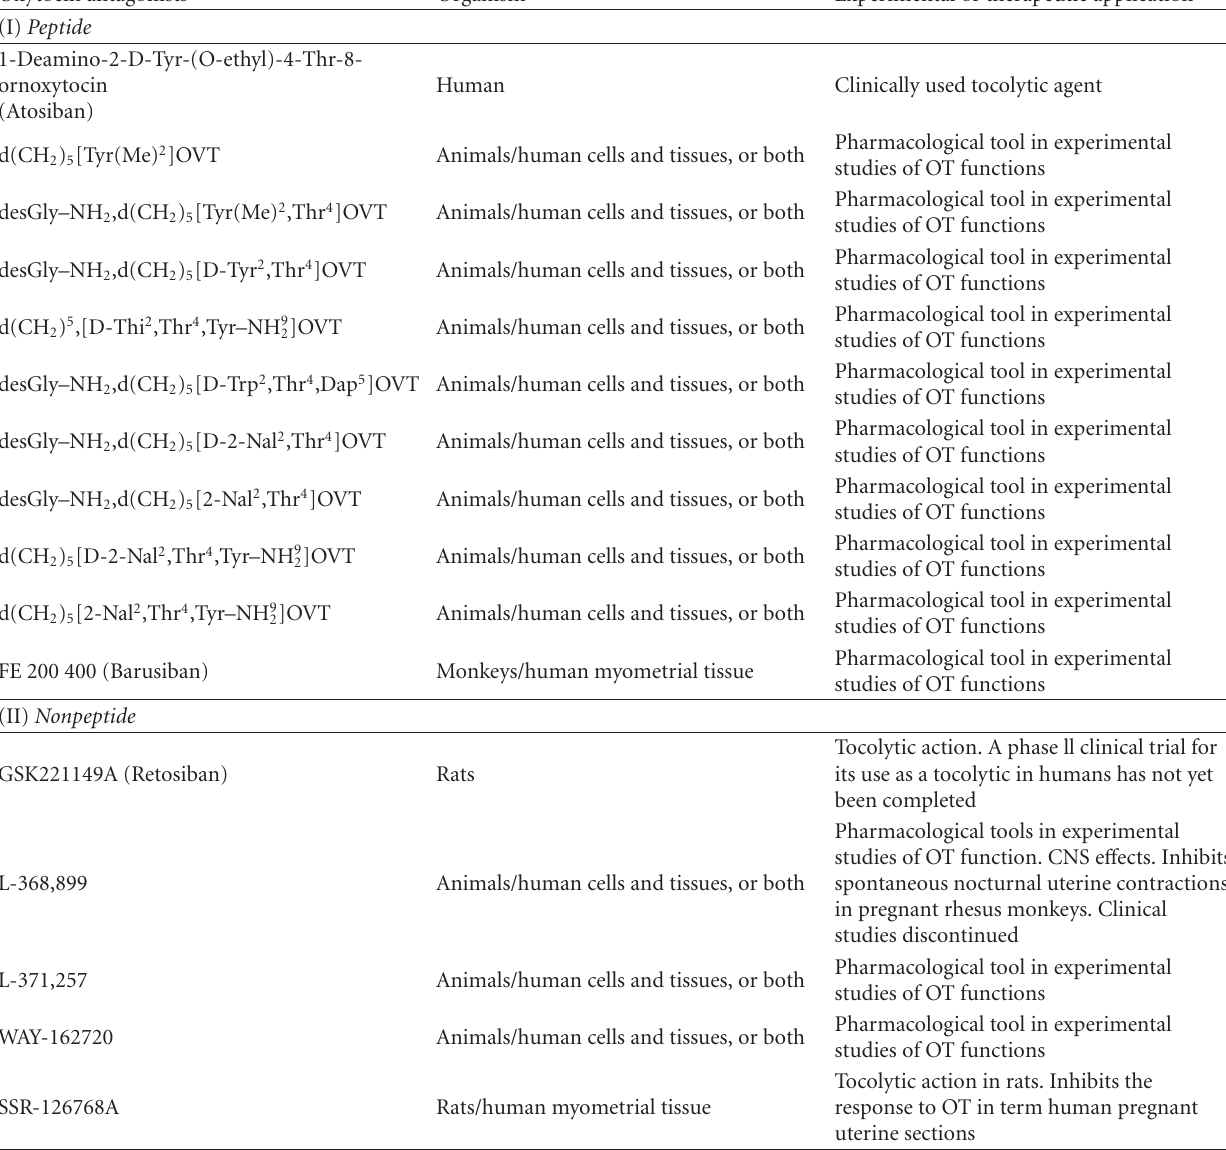
Table 1: The most extensively studied OT antagonists and their experimental or clinical